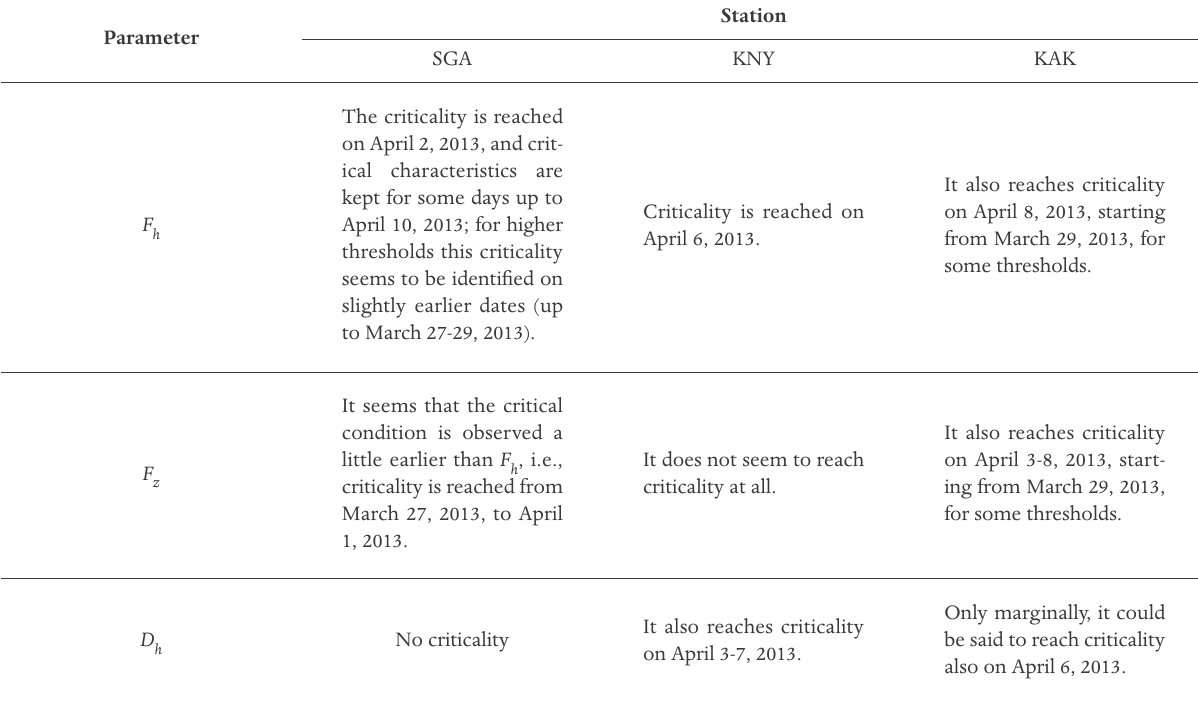
Table 1. Summary of natural time analysis results for F